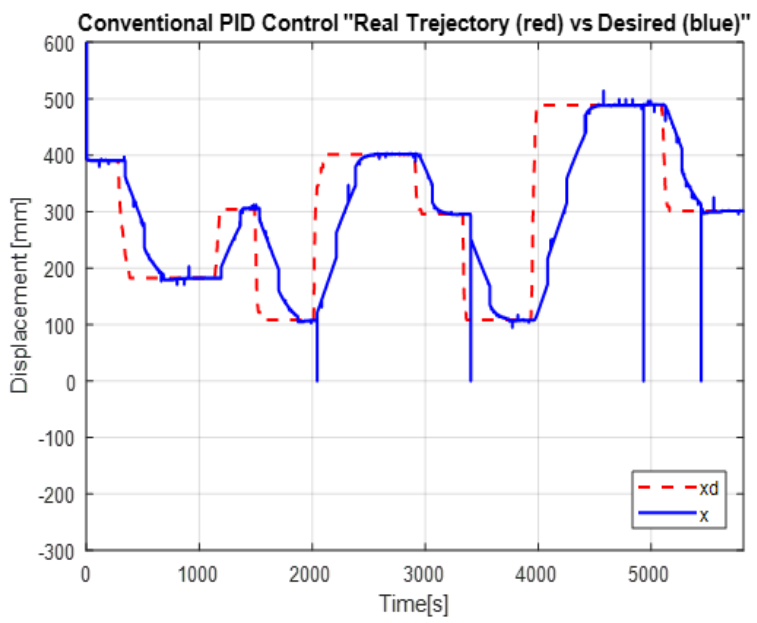
Figure 13. Real vs. desired trajectory (position change) of the conventional